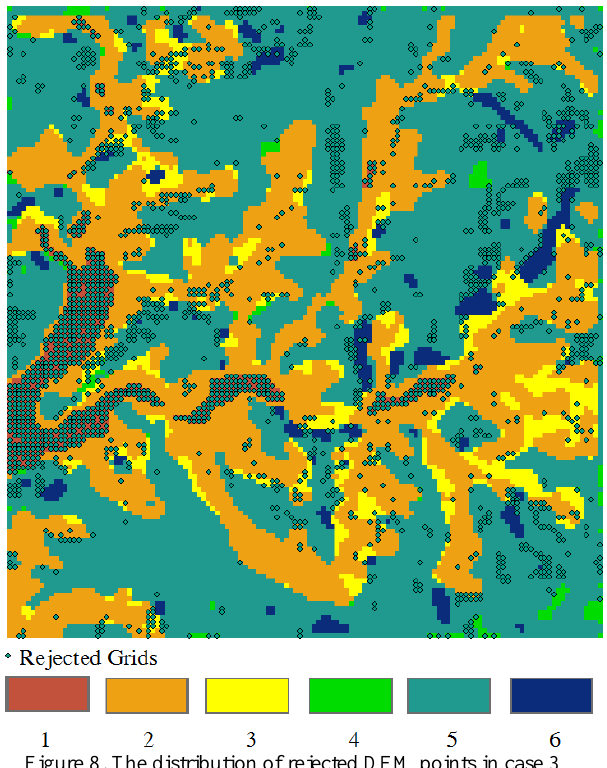
Figure 8. The distribution of rejected DEM points in case 3 4.3.2 Blunder Detection with and without Classification